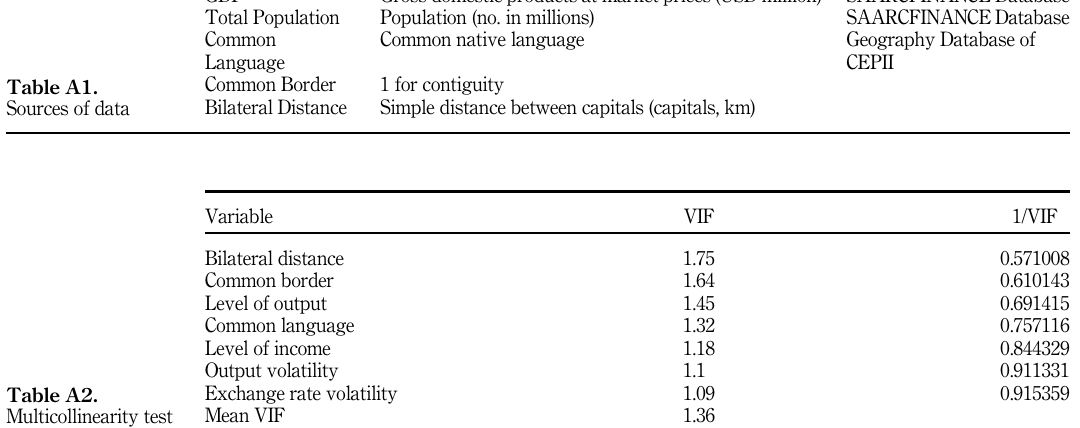
Table A2. Multicollinearity